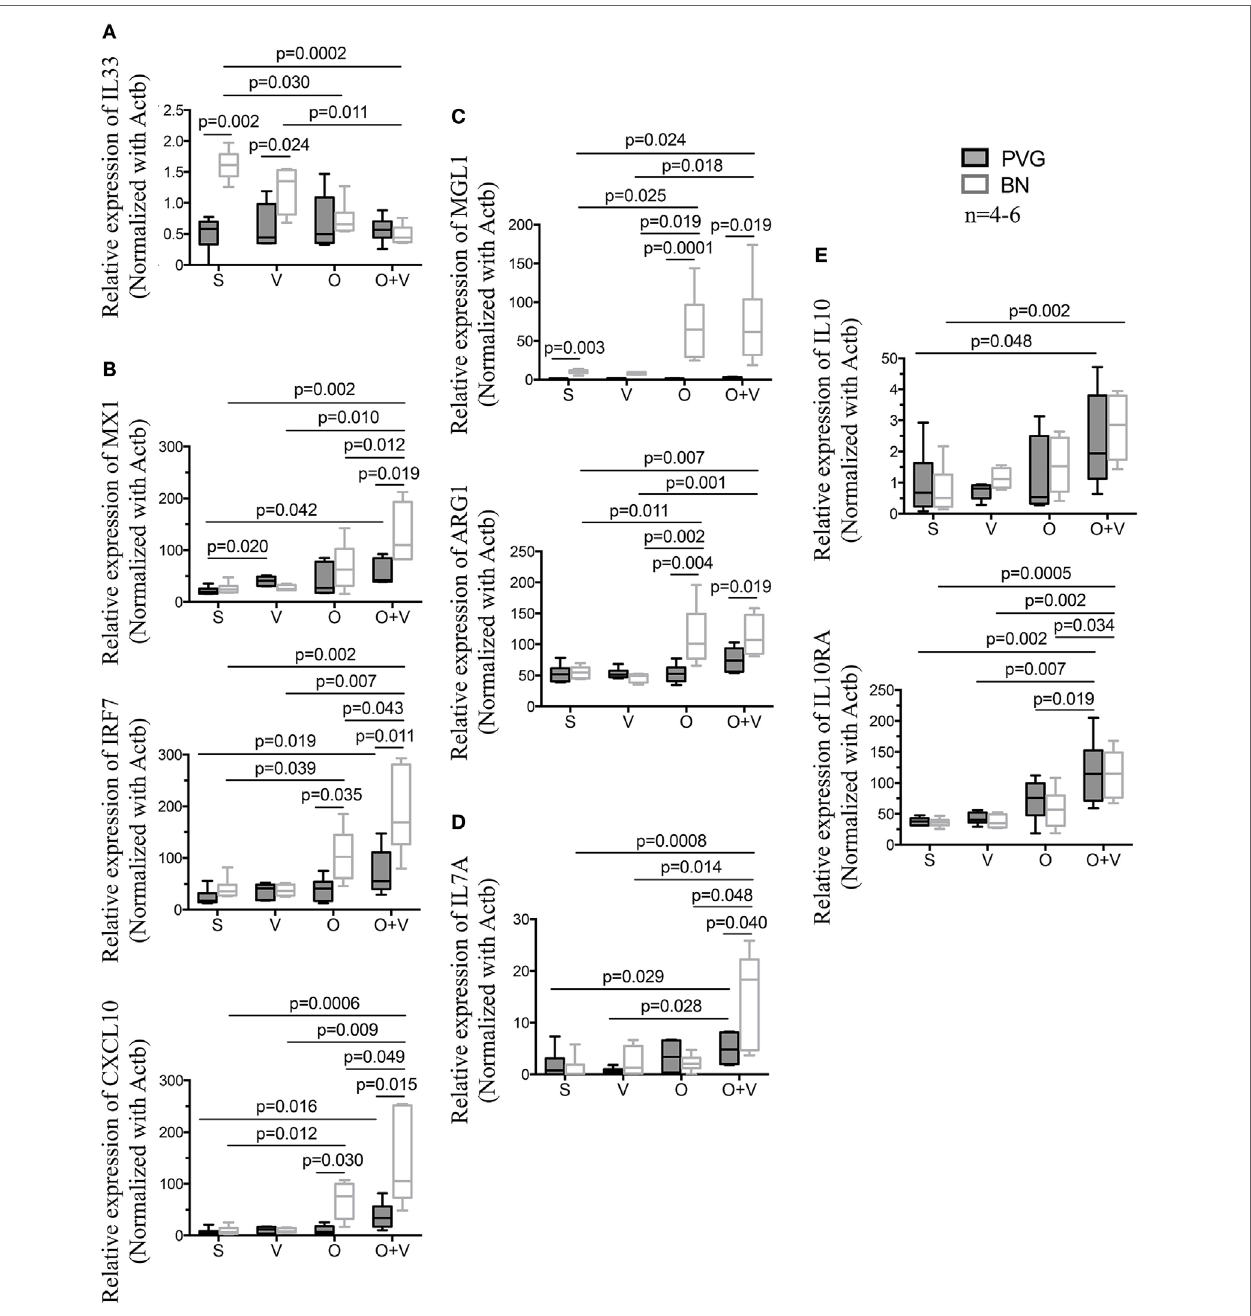
FigUre 5 | Co-exposure to virus and allergen induces a mixed type I IFN and Th2 gene signature in BN rats. PVG ( ◾ ) and BN ( ◽ ) rats were sensitized (S) with OVA/ alum 14 days prior to vMC 0 infection (V), OVA allergen challenge (O) at day 1 post-infection (Dpi1). Bronchoalveolar lavage cells were collected at Dpi2 and total RNA was extracted. Real-time quantitative PCR of a subset of genes representative of the main pathways identified in Figure 2 was carried out. (a) IL33 gene expression; (B) Type I interferon and antiviral response genes; (c) alternative activation of macrophages; (D) IL17a; and (e) immunoregulatory genes. All animals were sensitized to OVA/alum. n = 4–6; statistical analysis was carried out by non-parametric Kruskal–Wallis test followed by Dunn’s multiple comparisons (overall p -values, IL33: 0.002; MX1: 0.009; IRF7: 0.0005; CXCL10: 0.0007; MGL1: 0.0001; ARG1: 0.0005; IL17A: 0.009; IL10: 0.016; and IL10RA: